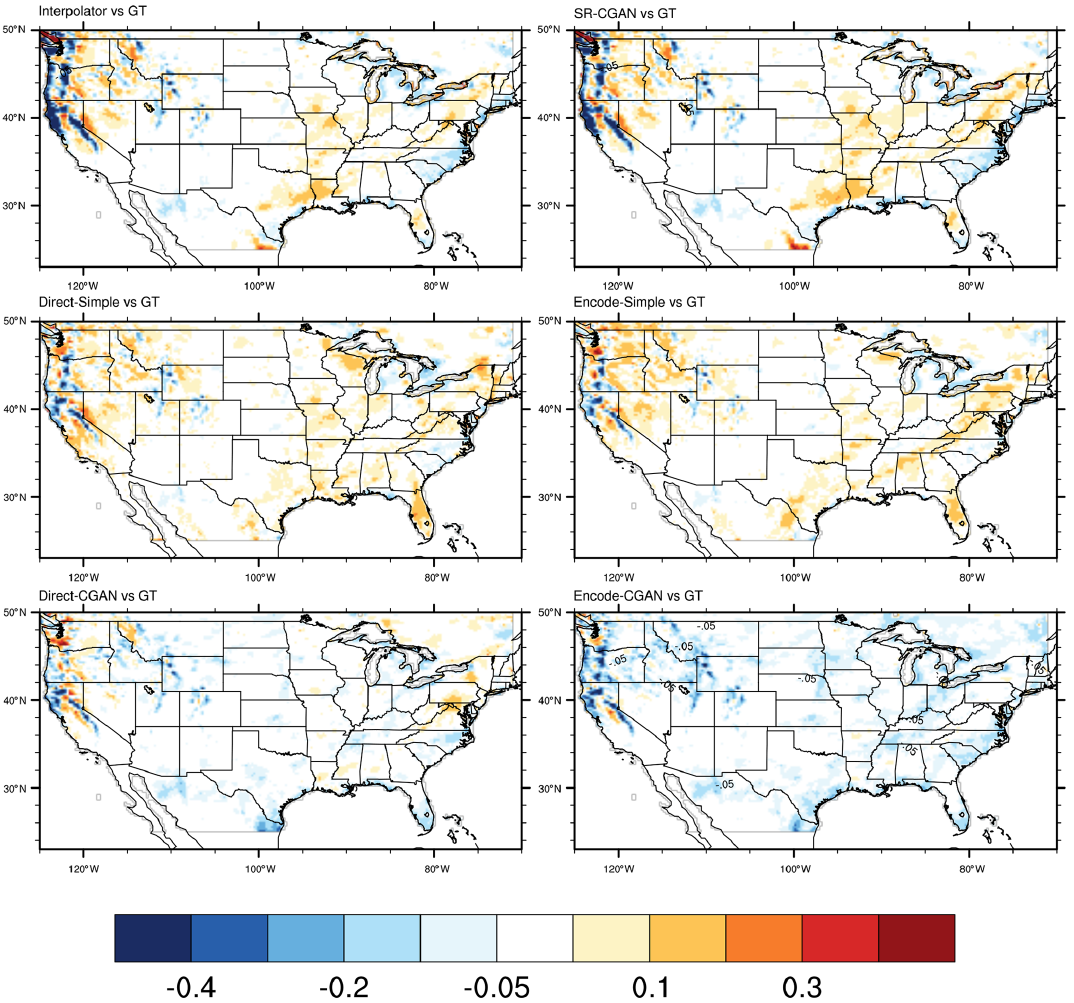
Figure 8. The differences (predictive models vs. Ground Truth) of mean precipitation (mm/3h) produced by Ground Truth, Interpolator, and five CNN models for the testing period